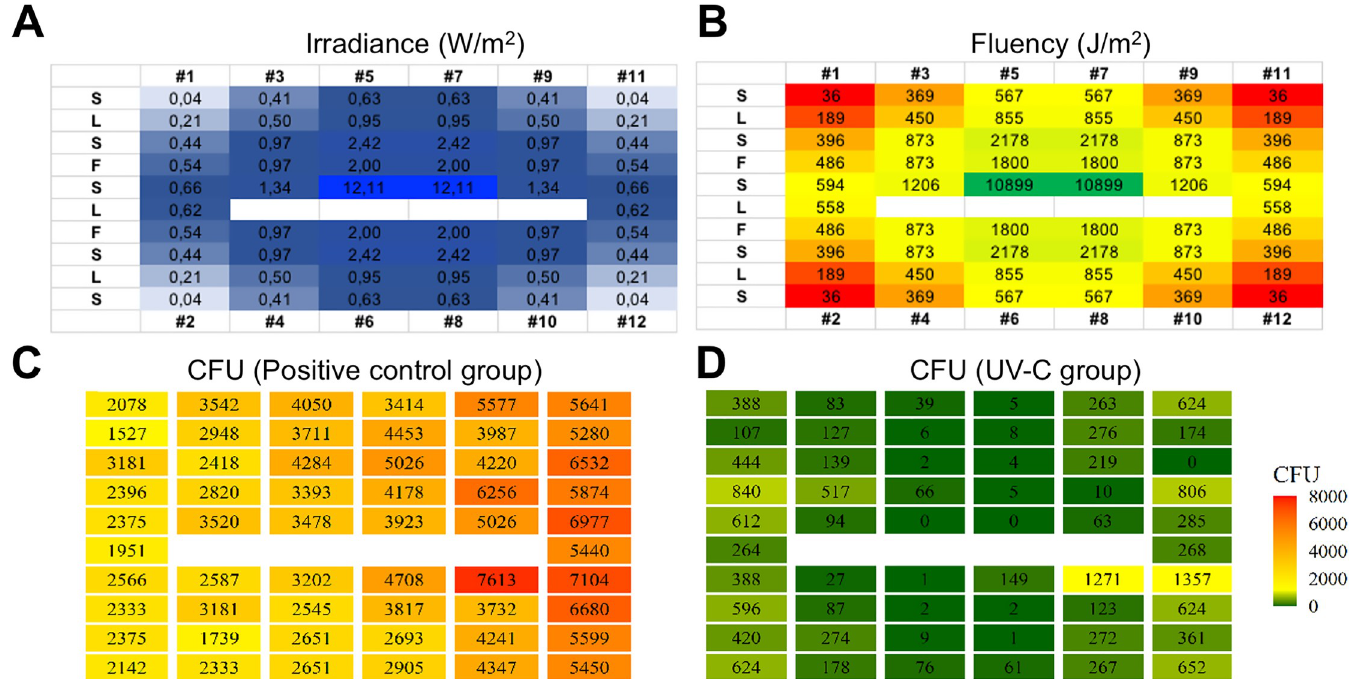
Fig 5. Data and heat map of irradiance (W/m 2 ) and fluency (J/m 2 ) in the clinic group UV-C. S = Stand; L = fluorescent lamp fixtures; F = floor; # (number) Position of dental equipment.